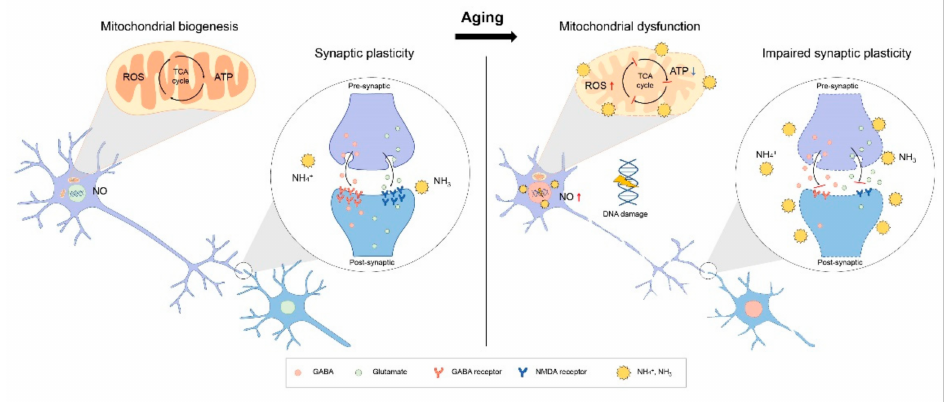
Figure 2. Mitochondria dysfunction and impaired synaptic plasticity in aged